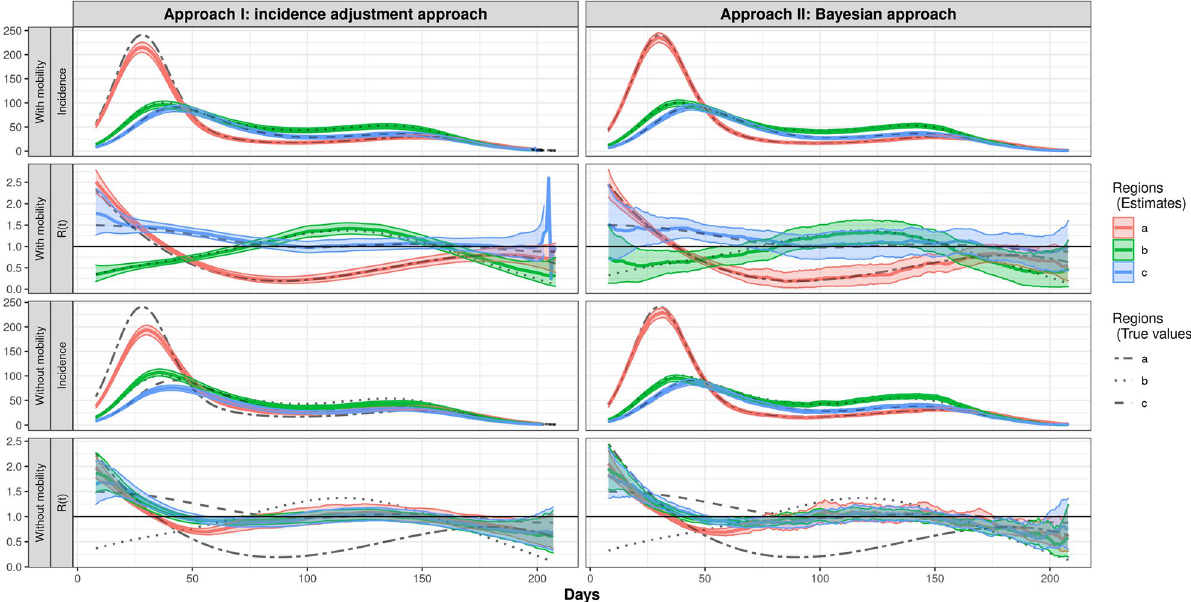
Fig 2. Estimated E [N( t )] and R ( t ) by region for Scenario 1. Solid lines are posterior means, along with the 95% credible bands (shaded). As noted at the sidebars on the left, the figures in the upper panel are the estimated Incidence and R ( t ) by region while using mobility data, and the lower panel shows the results from models without using mobility data. Both the results from Approach I and Approach II are provided.